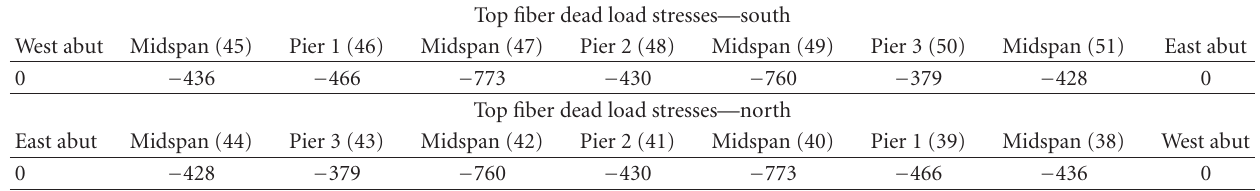
Table 8: Deck dead load stresses (psi ∗ ).